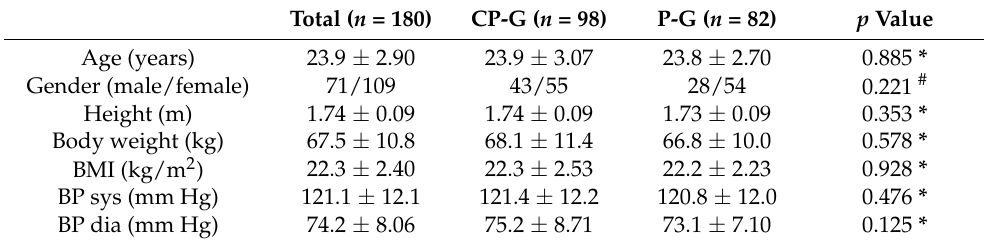
Table 1. Baseline data (T0) for the PP population ( n =